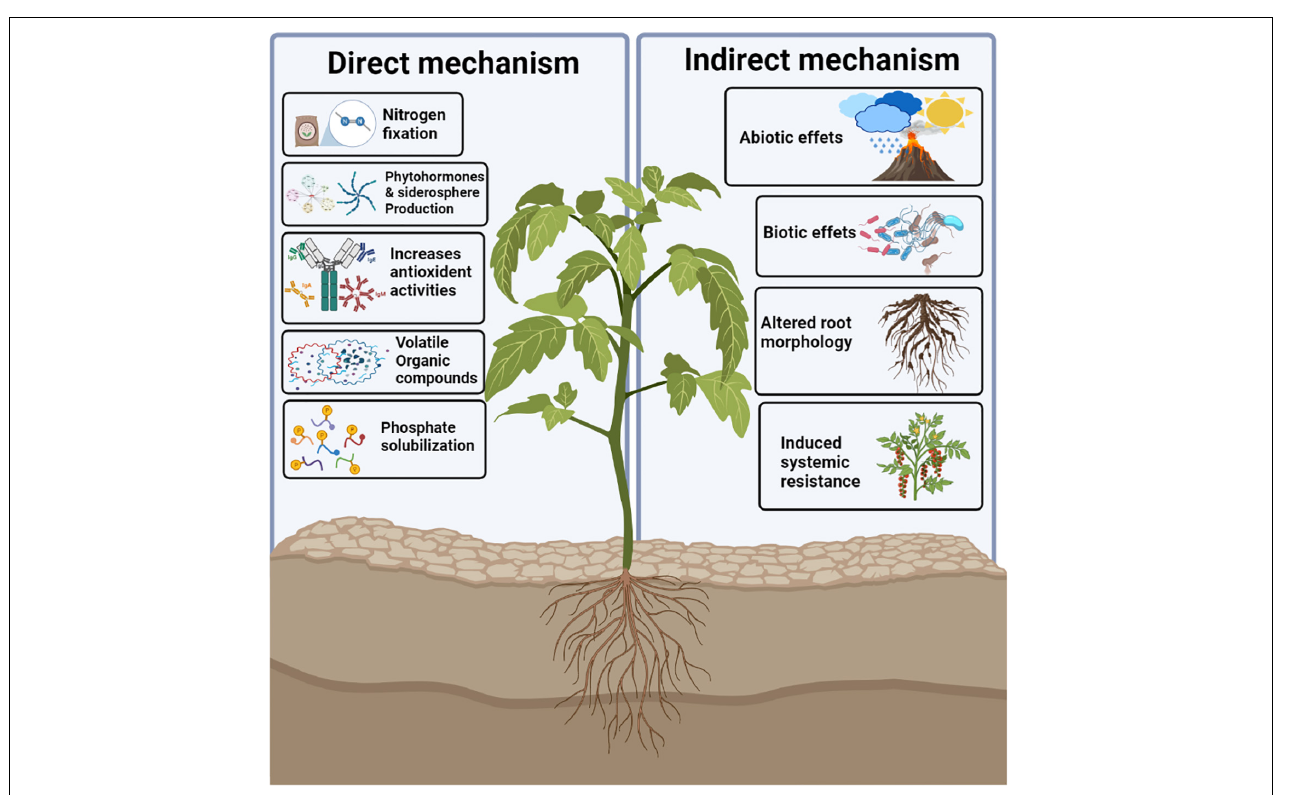
FIGURE 1 | Morphological, physiological, and molecular response to drought stress in